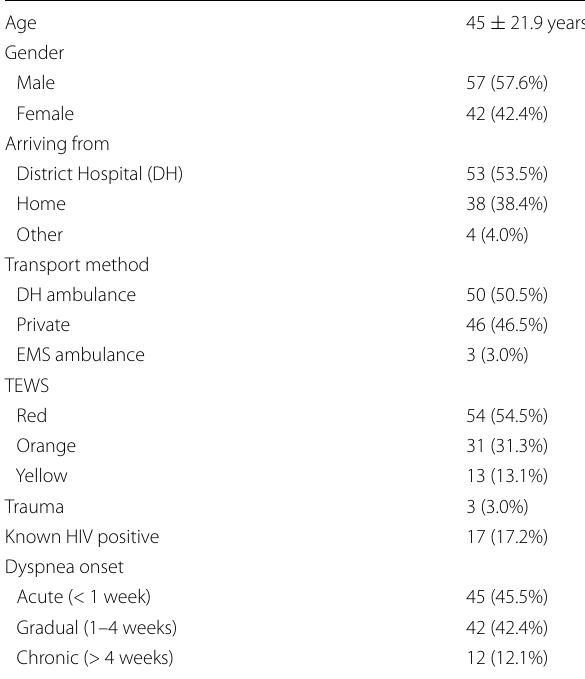
Table 1 Population characteristics ( n